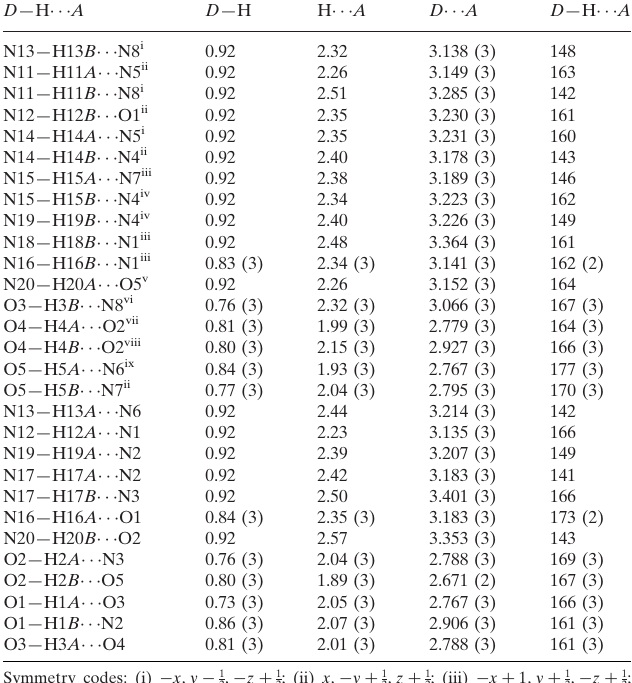
Hydrogen-bond geometry (A˚ , (cid:3)